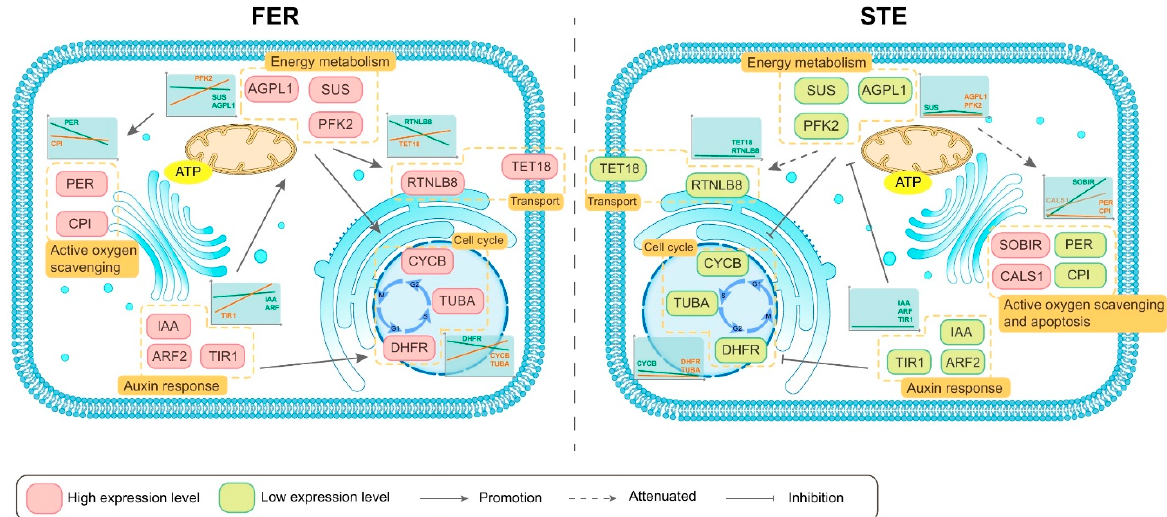
Figure 9. Speculative network model revealing the ovule abortion in a sterile female line of Pinus tabuliformis Carr. SUS: Sucrose synthase; AGPL1: ADP-glucose pyrophosphorylase large subunit 1; PFK2: ATP-dependent 6-phosphofructokinase 2; TET18: Tetraspanin-18; RTNLB8: Reticulon-like protein B8; CLV1: Clavata 1-like protein; CYCB: Cyclin B; TUBA: Tubulin alpha chain; DHFR: Dihydrofolate reductase; SOBIR1: Leucine-rich repeat receptor-like serine/threonine/tyrosine-protein kinase SOBIR1; CPI: Cysteine proteinase inhibitor; PER: Peroxidase; CALS3: Callose synthase 3; IAA: Auxin-responsive protein IAA; ARF2: Auxin response factor 2; TIR1: Transport inhibitor response